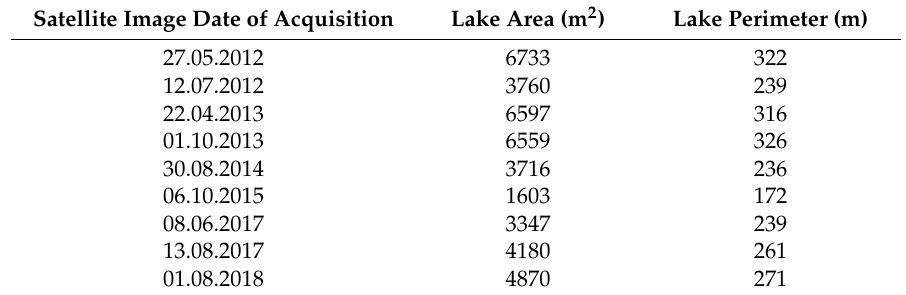
Table 2. Changes in pro-glacial lake area between 2012 and 2018, based on satellite images from Google Earth.